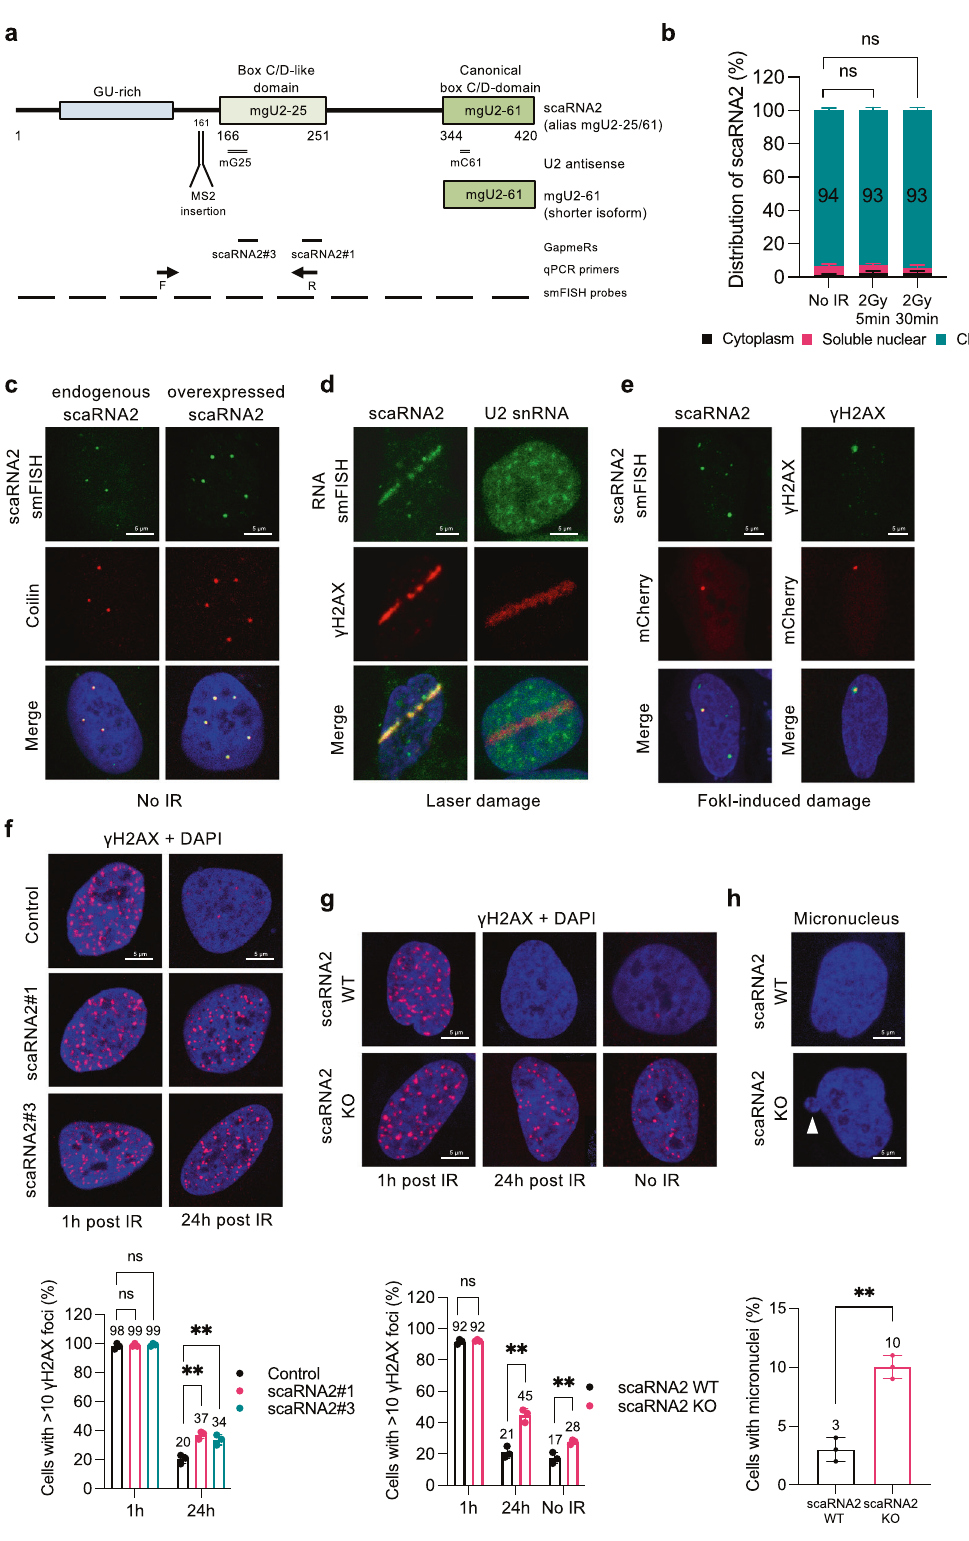
(Fig. 1c and Supplementary Fig. 2a). The speci fi city of the scaRNA2 FISH staining was con fi rmed by showing that its signal was reduced by knockdown employing antisense LNA oligonucleotides (Gap- meRs) (Supplementary Fig. 2b). The expression of other scaRNAs was not changed upon depletion of scaRNA2 (Supplementary Fig. 2c). NATURE COMMUNICATIONS| (2022) 13:1015 |https://doi.org/10.1038/s41467-022-28646-5|www.nature.com/naturecommunications